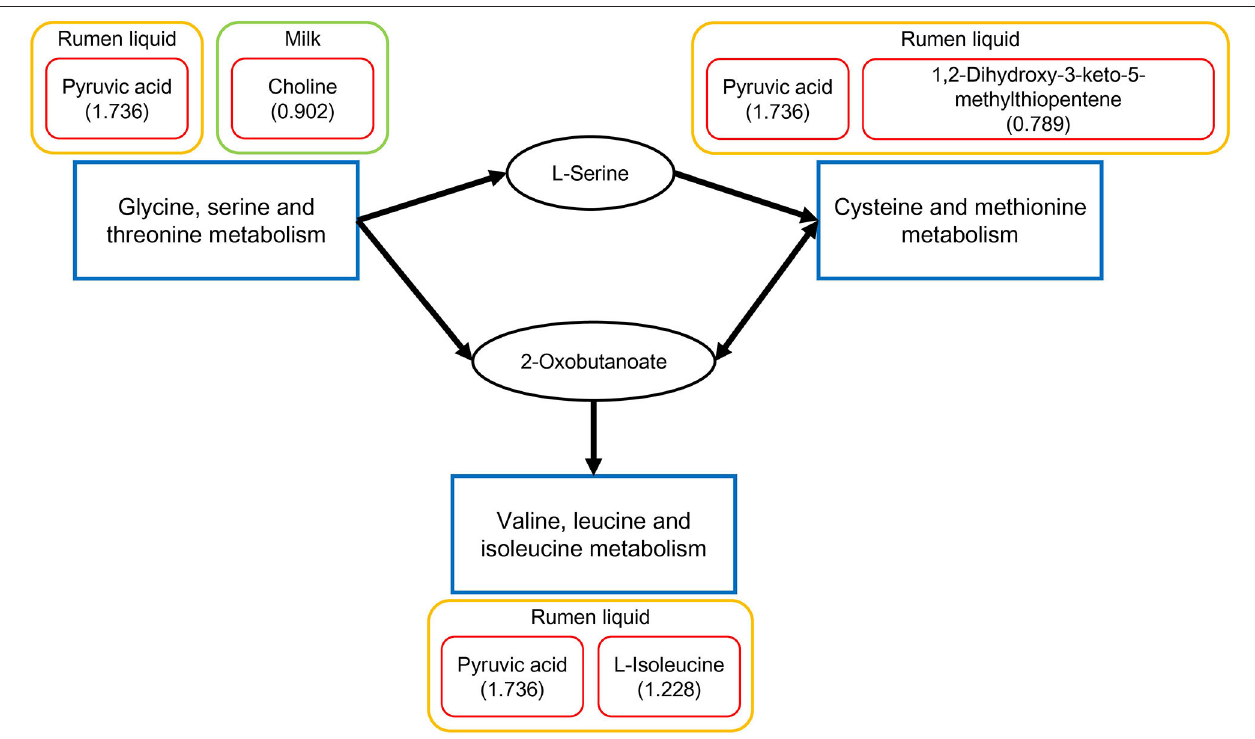
FIGURE 5 | Integrated key differential metabolic pathways and relevant significantly different metabolites in each biofluid between the two dietary treatments. The significantly different metabolites in each biofluid for each pathway are displayed in the red boxes. Each number in the parentheses is the fold change of the corresponding metabolite, which is the ratio of the quantity of the metabolite in the FSBM group to that in the SBM